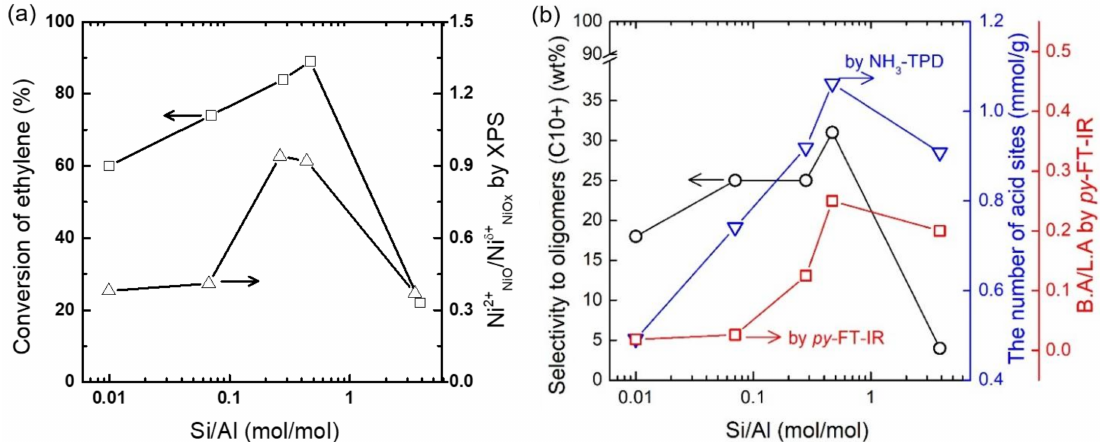
Figure 7. Comparisons between ( a ) ethylene conversion and Ni 2 + / Ni δ + ratio determined by XPS and ( b ) selectivity to C10 + oligomers and total number of acid sites and B.A / L.A ratio determined by NH 3 -TPD and py -FT-IR, respectively. Conversion and selectivity are the average values obtained after the entire reaction time of 16 h performed at 200 ◦ C, 10 bar, and 0.375 h − 1 WHSV. The Ni 2 + / Ni δ + ratio was derived from the deconvoluted area ratio of NiO and NiO x Ni 2p 3 / 2 XPS